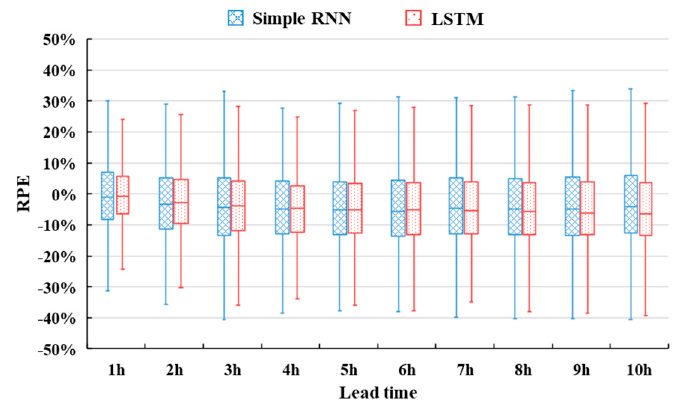
Figure 13. RPE for different RNN approaches at 1–10 ‐ h lead ‐ time.